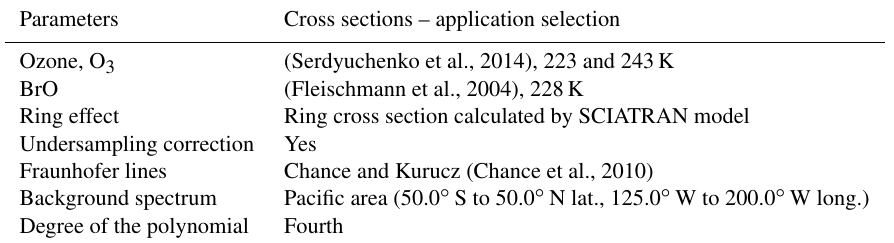
Figure 1. Time series of (a) SCDs of BrO (moleccm − 2 ) over the Pacific, (b) fitting RMSE over the Pacific and (c) fitting RMSE over the Arctic. GOME data are shown in red, SCIAMACHY in blue, GOME-2A in green and GOME-2B in brown color. Table 2. Parameter selection for all